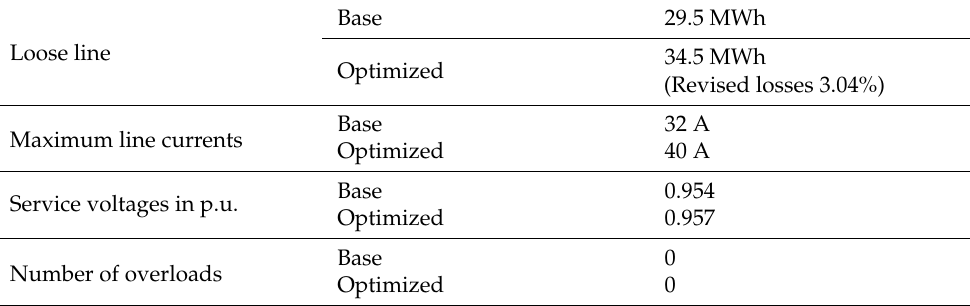
Table 3. Compare the optimized case of the study.